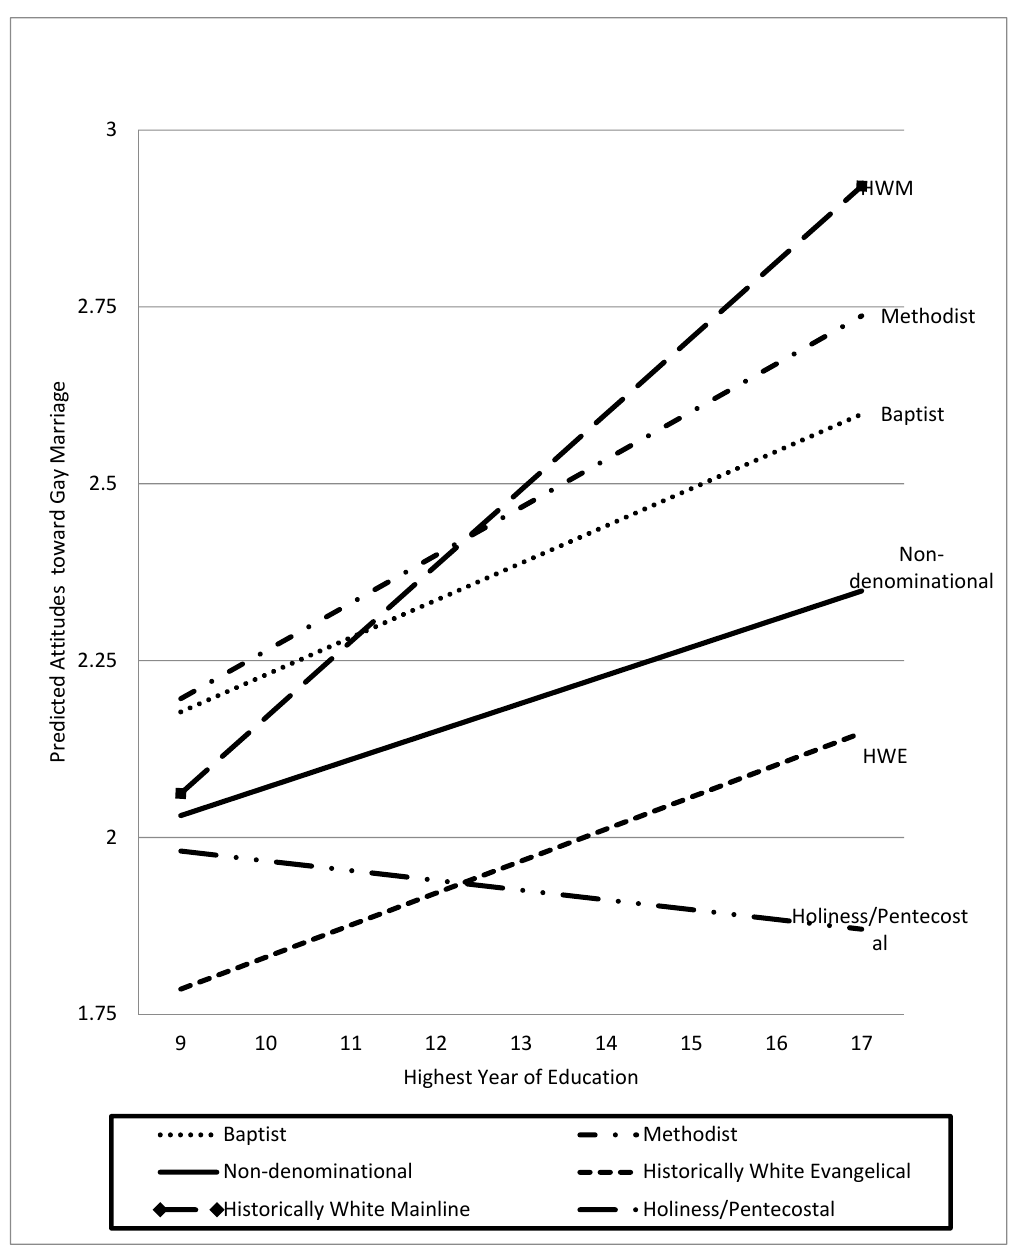
Figure 10. The interaction of education and religion for Black Protestant views on gay marriage.